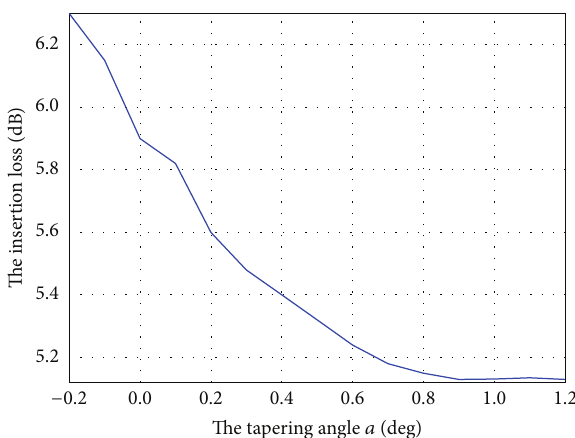
Figure 8: Insertion loss as the tapering angle 𝑎 varies.